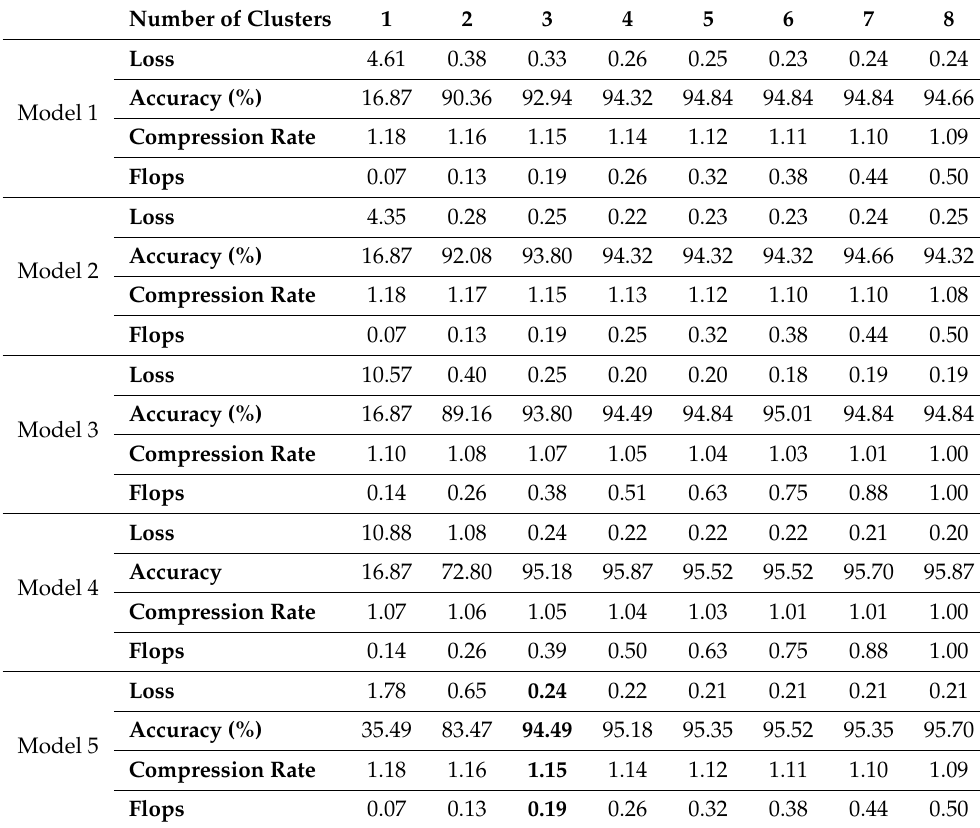
Table 8. Results for scalar quantization on convolutional layers